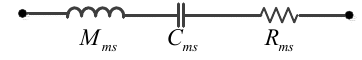
Figure 4. Equivalent circuit of mechanical domain.